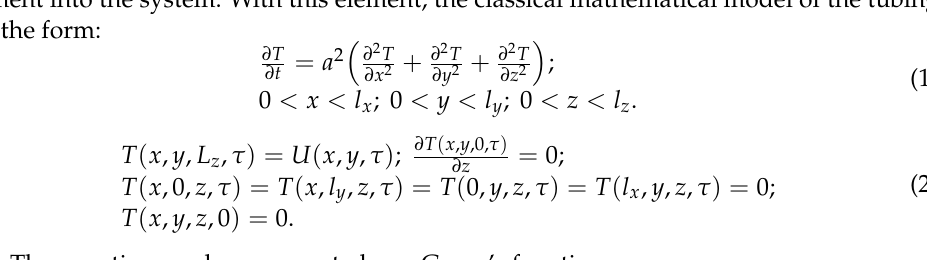
Figure 4. Scheme of information flows of an oil well with installed heating elements.